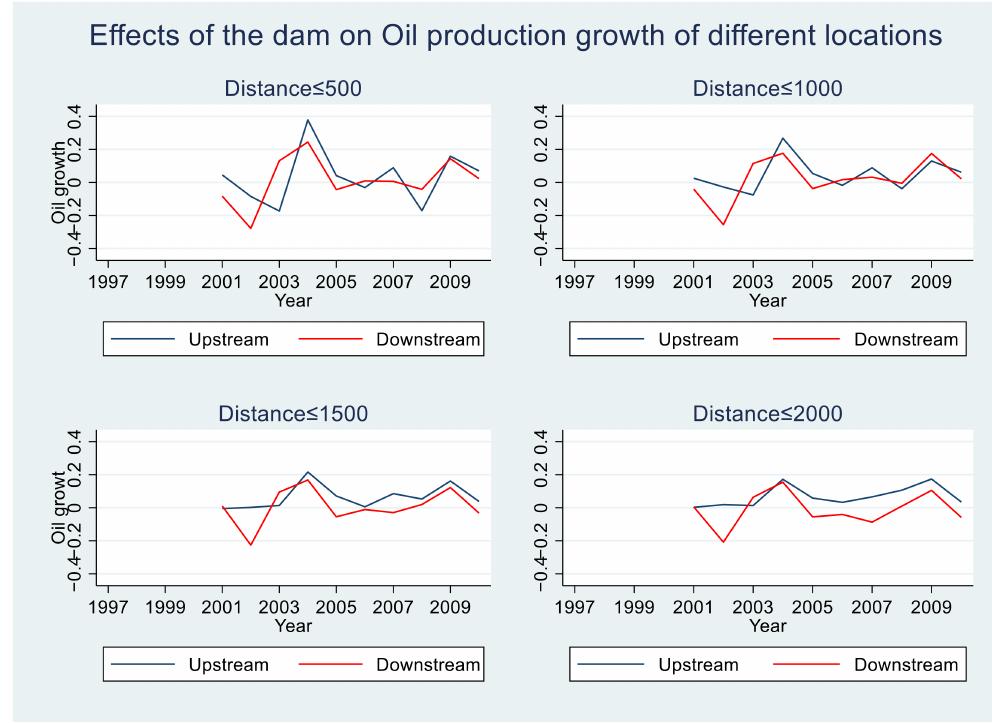
Figure 4. Effects of the damming on the growth rate of oil production for upstream and downstream counties. Note: the unit of the distance in each graph is